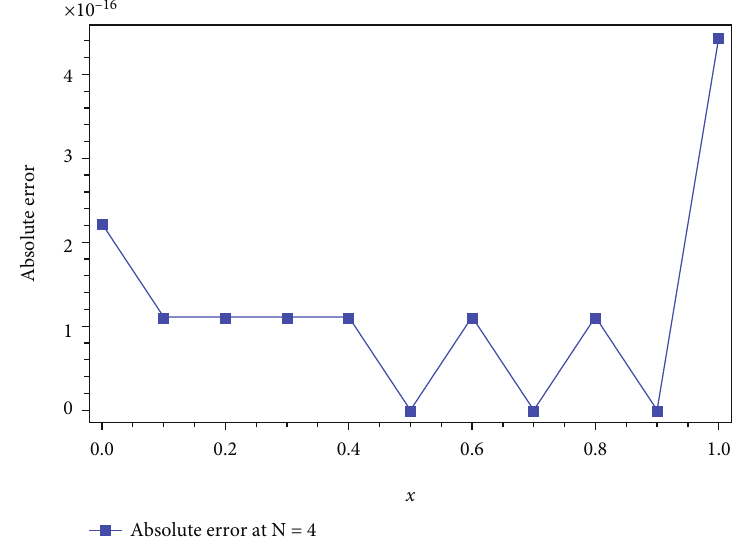
Figure 6: Exact solution and numerical solutions of Example 4-case 1 for di ff erent values of N , h .